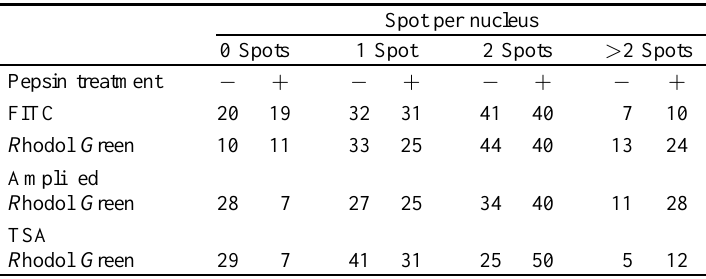
Table 2b Effect of pepsin treatment on automated scoring